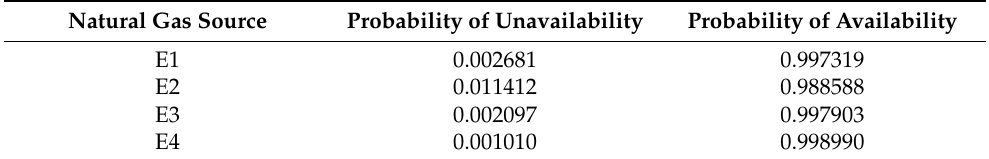
Table A10. Availability and unavailability of major natural gas sources in the eastern gas network. Natural Gas Source Probability of Unavailability